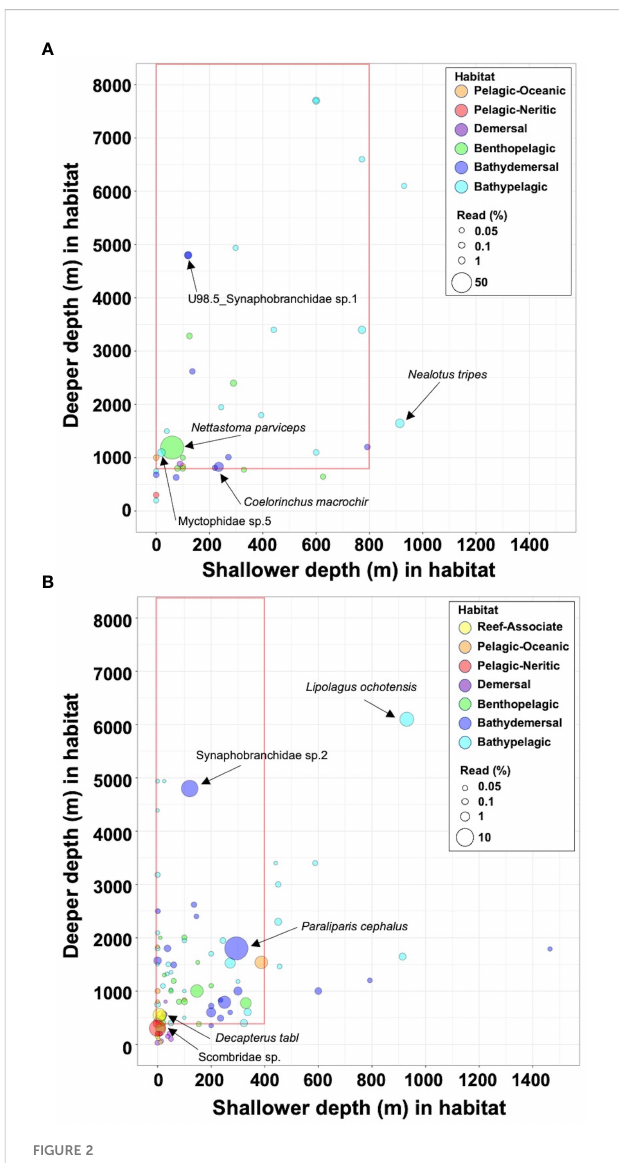
FIGURE 2 Range of habitat depth records for fi sh species detected from eDNA. The shallowest and deepest recorded depths of habitats of detected fi sh species obtained from FishBase (https://www. fi shbase.se/home. html) are denoted by circles on the X and Y axes, respectively. Circles placed inside the red frames represent the species that can be distributed at the depth of each water intake (Akazawa: 800 m, Yaizu: 400 m). (A) Akazawa, (B) Yaizu. Circles of different colors indicate different habitat types classi fi ed by FishBase. Size of circles indicates the ratio of each OTU to the total reads. The names of the top fi ve species in most abundant reads and species below inlet depth, are shown as black and blue characters,